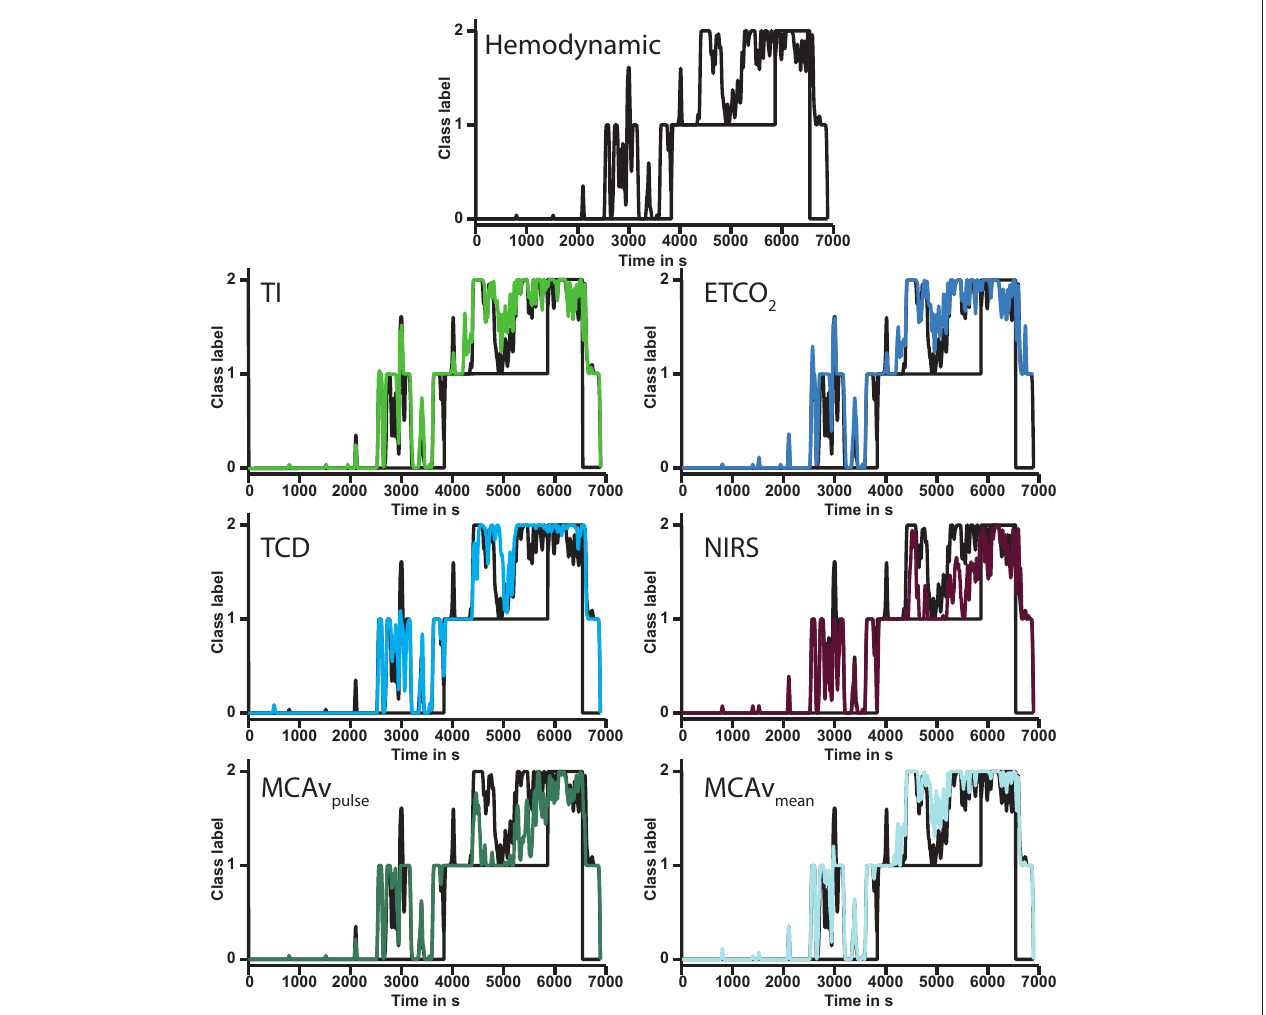
FIGURE 3 | Output of six models compared to BP curve dynamics model (#1, top ) in a single subject. Each subsequent graph shows the modulation of the addition of the annotated feature(s). In this subject the model for MCAv pulse height ( bottom left ) had the lowest error. Note that all model outputs increase with increasing duration of lower body negative pressure. ETCO 2 , end-tidal carbon dioxide pressure; TI, thoracic impedance; NIRS, near infrared spectroscopy; TCD, transcranial Doppler; MCAv, middle cerebral artery velocity; MCAv pulse , middle cerebral artery velocity pulse